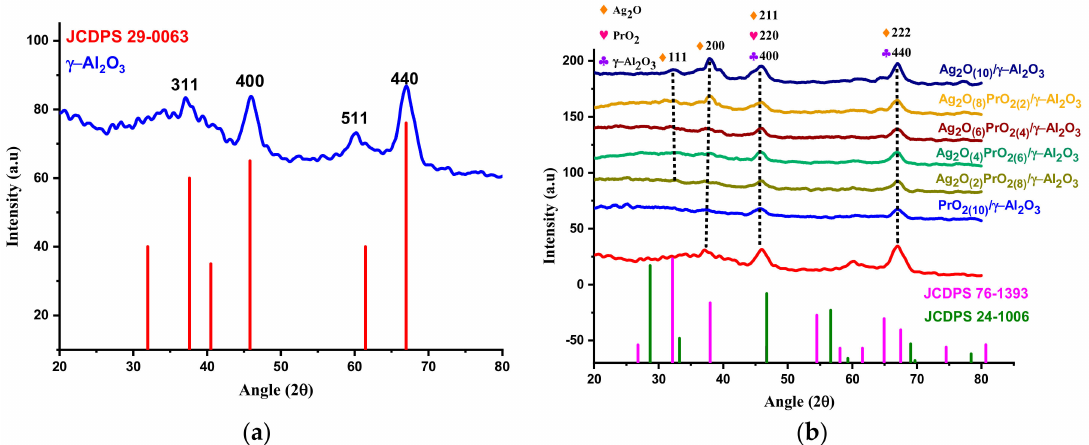
Figure 2. X-ray diffraction peaks of ( a ) γ -Al 2 O 3 with Joint Committee on Powder Diffraction Standards (JCPDS) card numbers. ( b ) Overlay of XRD peaks of γ -Al 2 O 3 and Ag 2 O ( X ) –PrO 2( Y ) / γ -Al 2 O 3 , along with JCPDS card numbers.